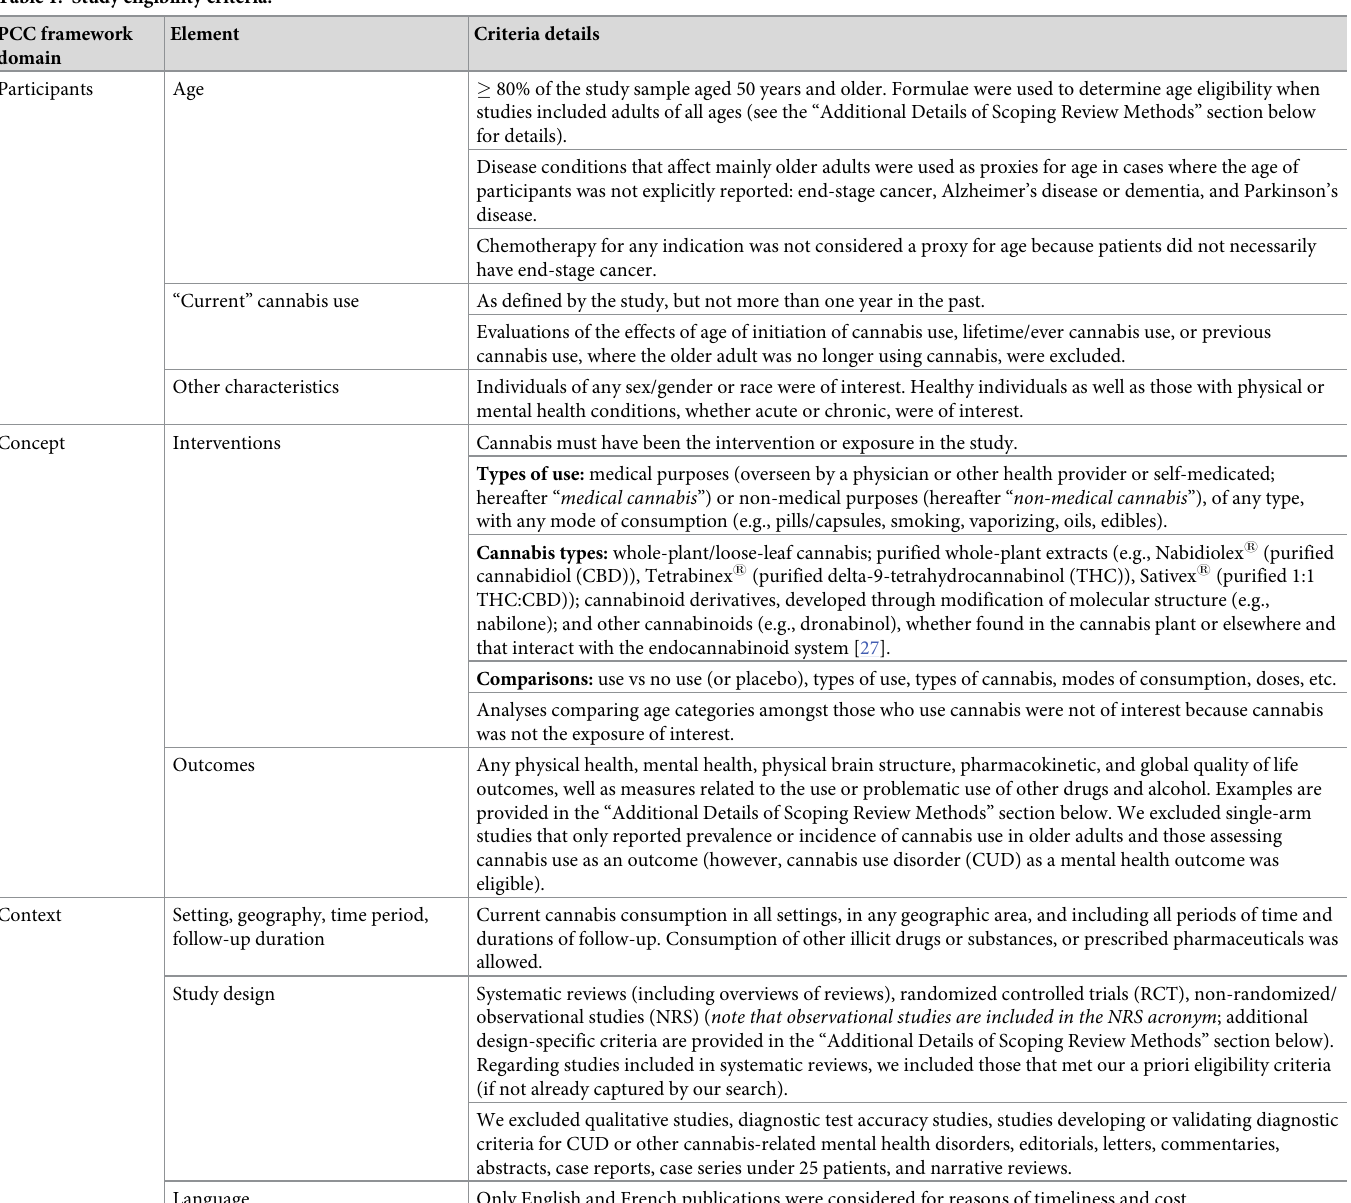
Table 1. Study eligibility